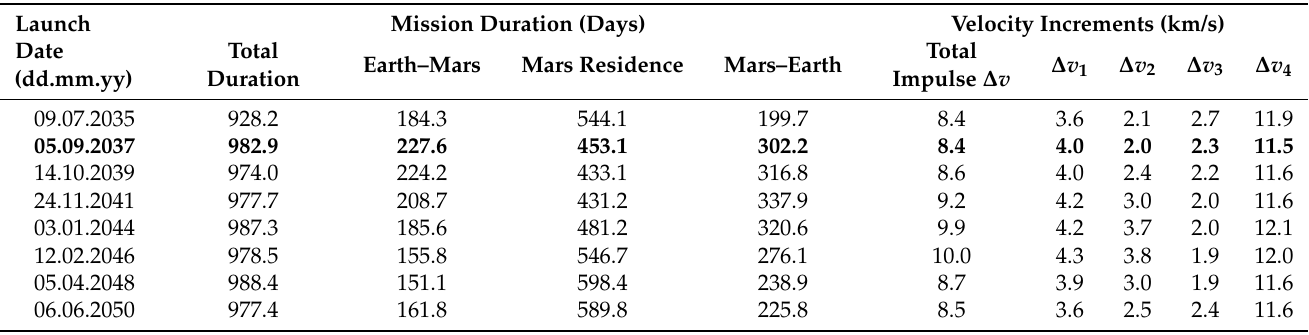
Table 2. Analogously, all actual ∆ v for orbit maneuver are conversed according to v ∞ . Table 2. Optimal mission profiles for manned Mars mission using chemical engines. Time of expedition: < 1000 days. The launch window is 2035–2050. The velocity increments in this table are all actual ∆ v departure from